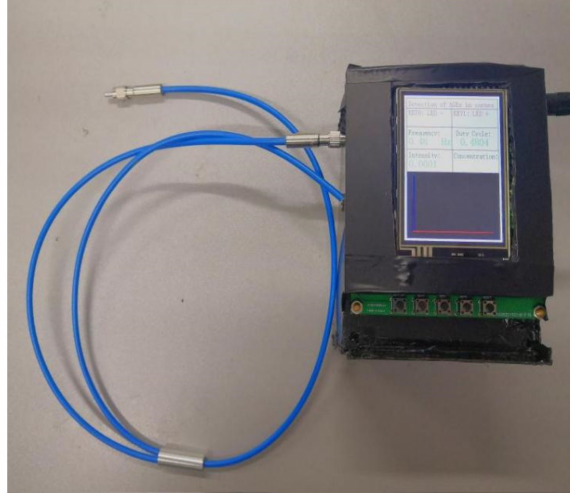
Figure 3. Physical view of the corneal fluorescence measurement